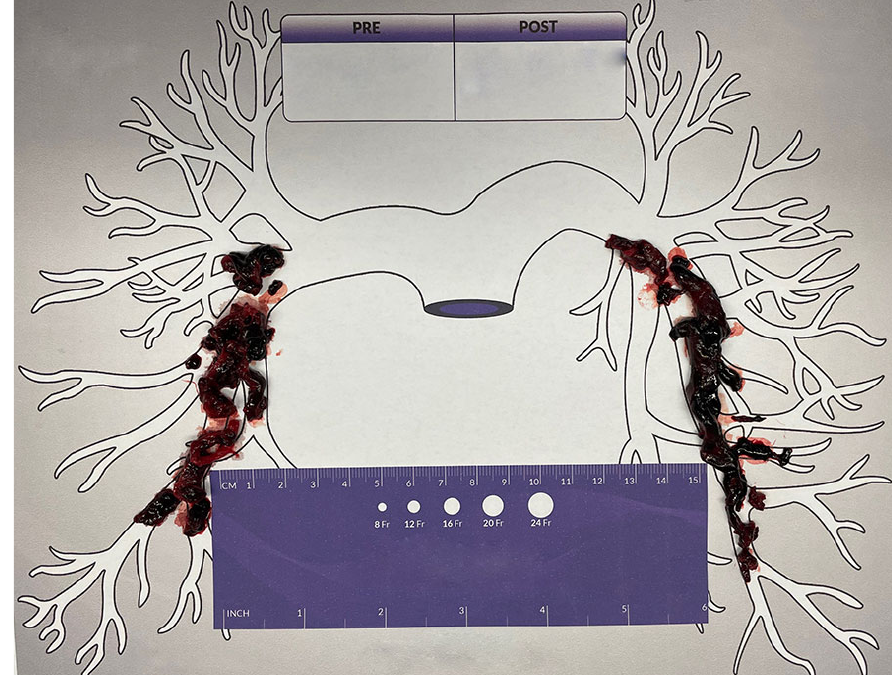
Figure 5. Retrieved thrombotic material and origin within the pulmonary artery system. procedures in the levels of hemoglobin, hematocrit, or platelets (Table 1).